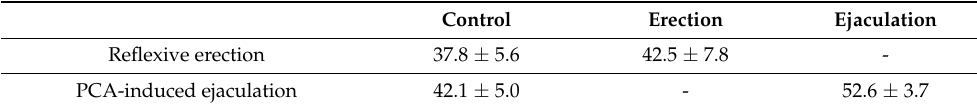
Table 2. The proportion of pERK expression in GRP-immunoreactive neurons (%) after reflexive erection or PCA-induced ejaculation.